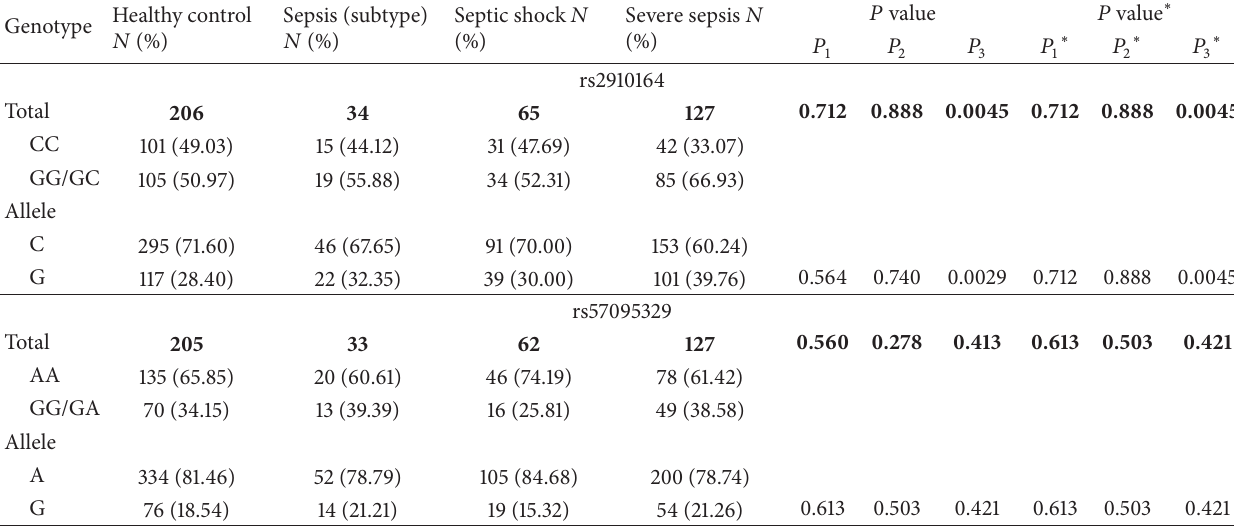
Table 3: Genotype and allele frequencies distribution in different sepsis status and healthy